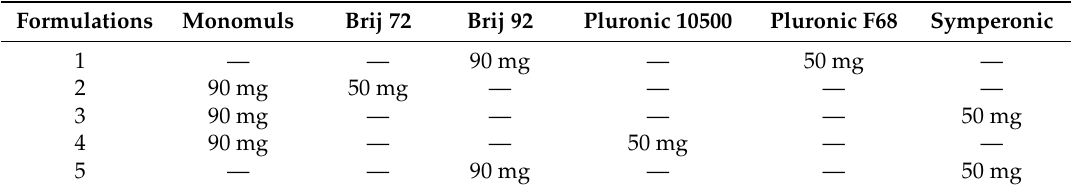
Table 1. Chemical compositions of lyotropic colloidal liquid